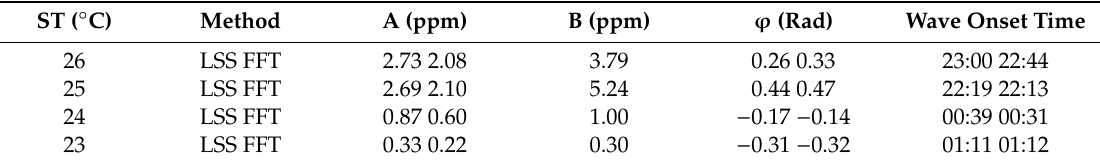
Table 3. Characteristic values of the sinusoidal curve at di ff erent setpoint temperatures. LSS: least squares setting; FFT: fast Fourier transform.